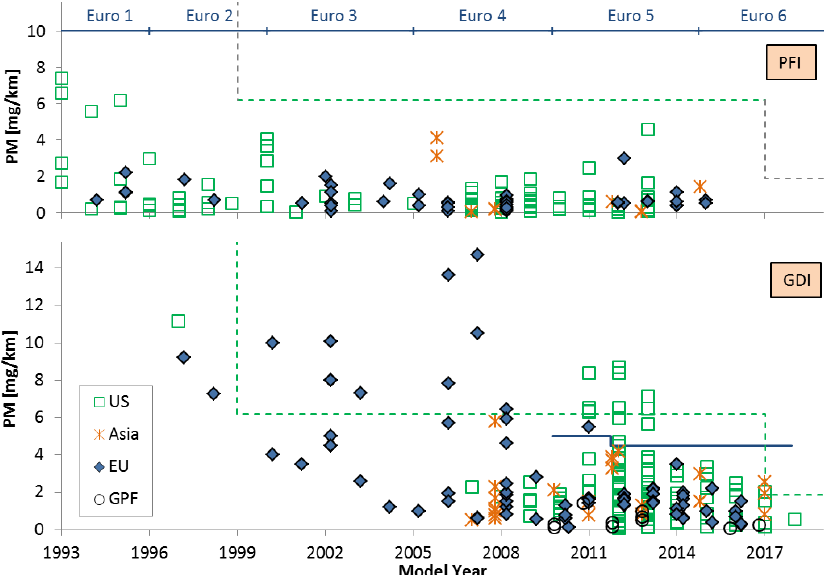
Figure 1. Particulate matter (PM) mass emissions for gasoline direct injection (GDI) (lower panel) and port fuel injection (PFI) (upper panel) vehicles. Solid line shows PM limits in EU for GDI vehicles. Dashed line shows the limits for gasoline vehicles (both GDI and PFI) in